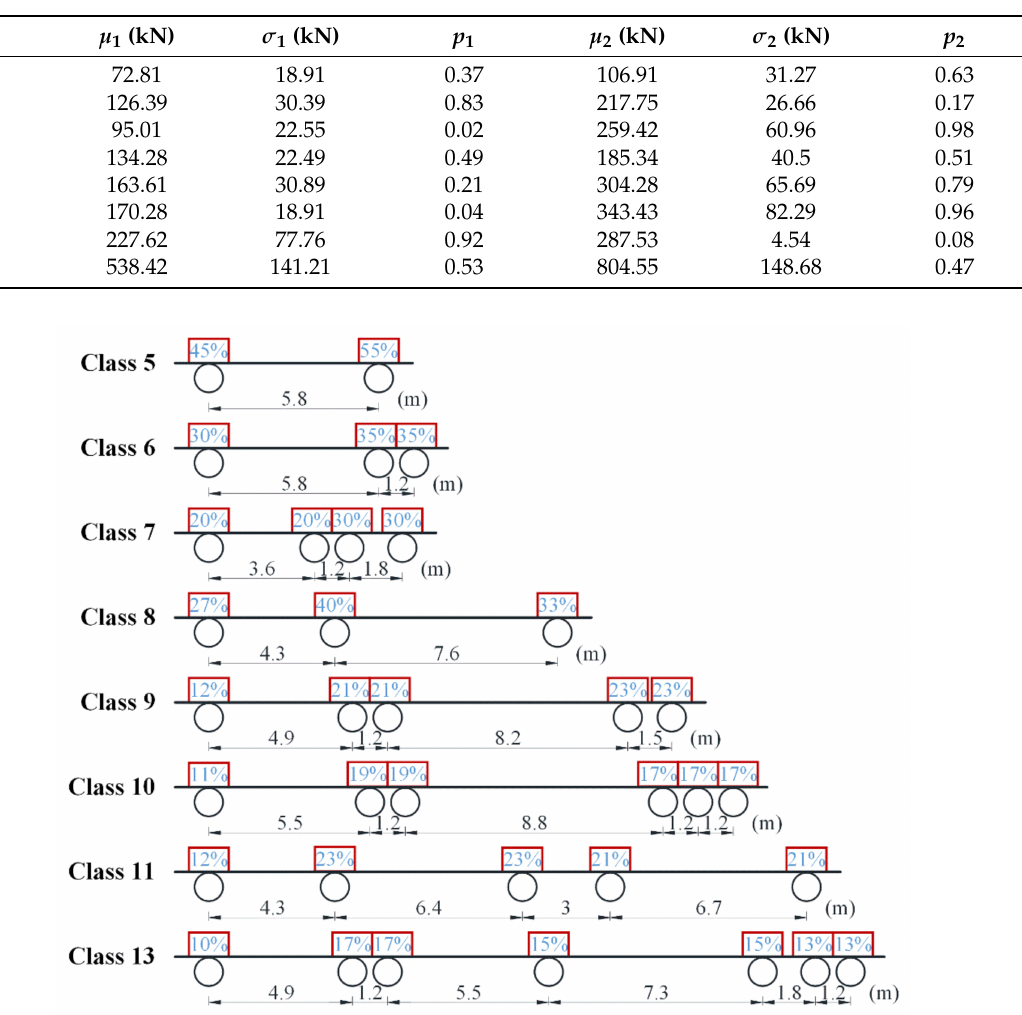
Table 1. Statistical parameters of the traffic load in Wisconsin.